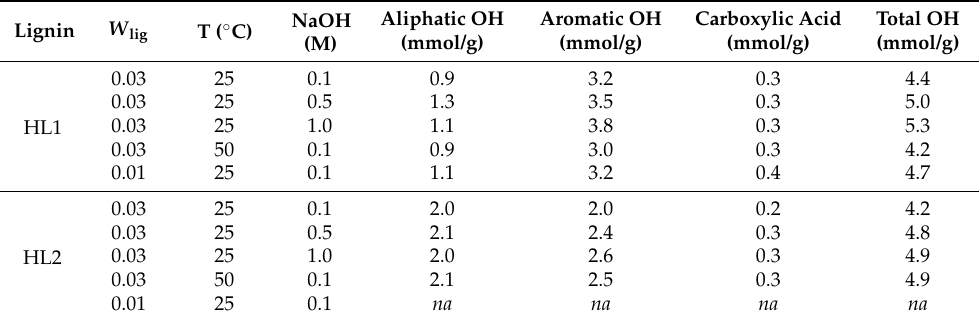
Table 1. Influence of NaOH concentration, temperature, and initial weight % lignin on the OH content of the purified lignin fractions for HL1 and HL2 lignins. Lignin W